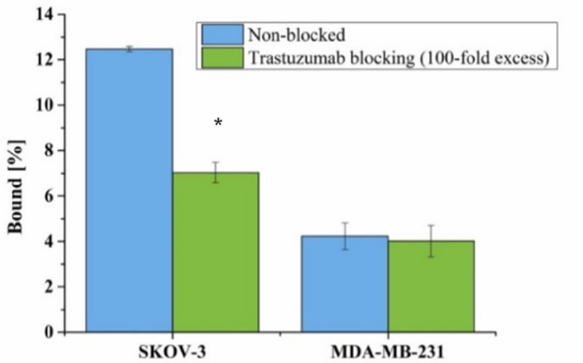
Figure 10. Specificity of binding on SKOV-3 (HER2+) and MDA-MB-231 (HER2 − ). [Ho]Fe 3 O 4 @Au- [ 131 I]Tmab was incubated in the presence and absence of 100x molar fold of free trastuzumab. Data are expressed as a mean ± SD ( n = 3). Statistical significance was considered if p < 0.05 (*).